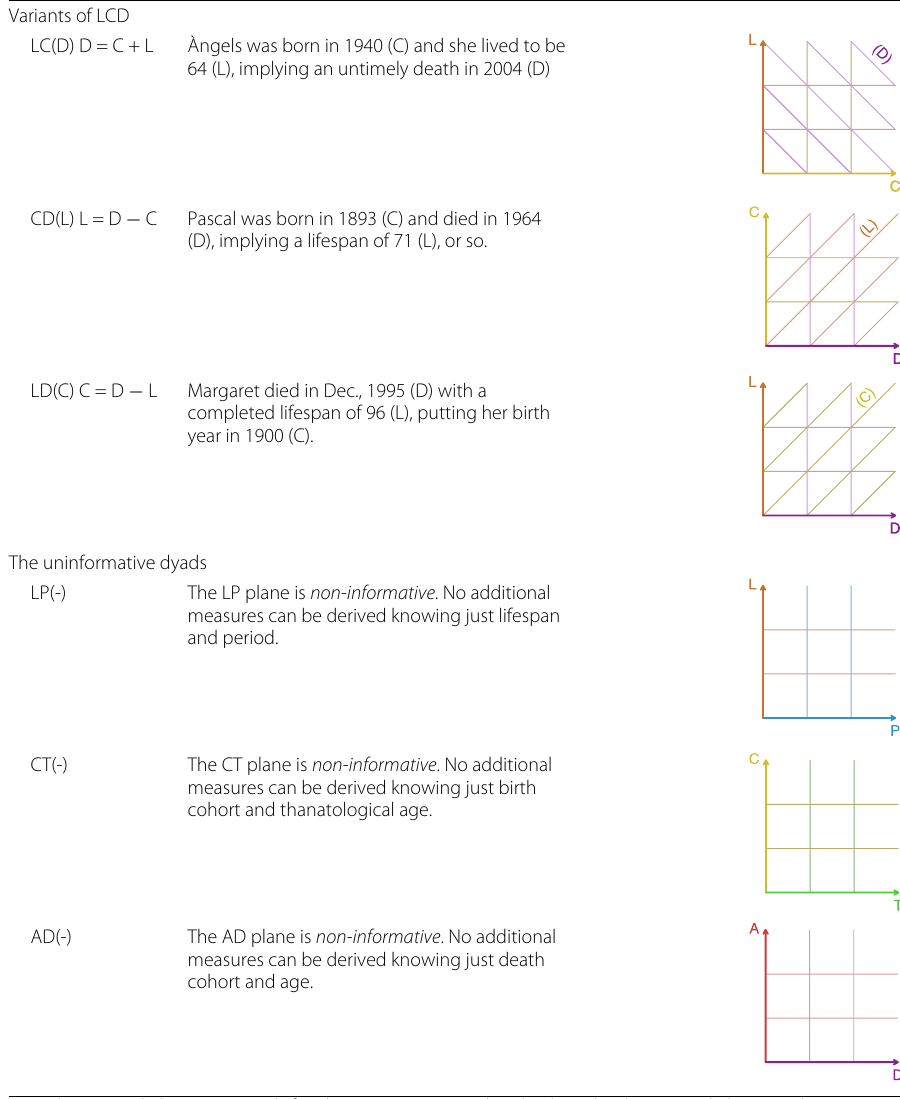
Table 2 All dyadic juxtapositions of the six measures of demographic time ( Continued ) Variants of